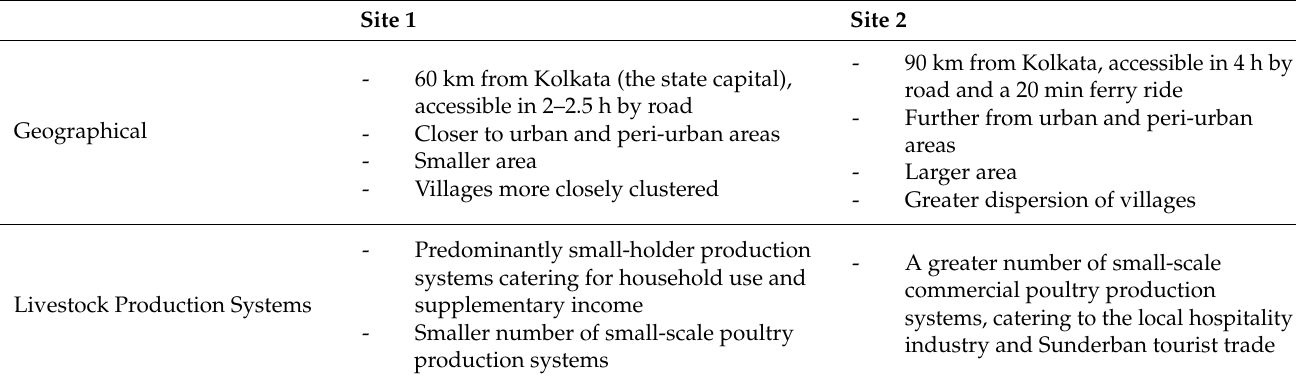
Table 3. Major Differences between Site 1 and Site